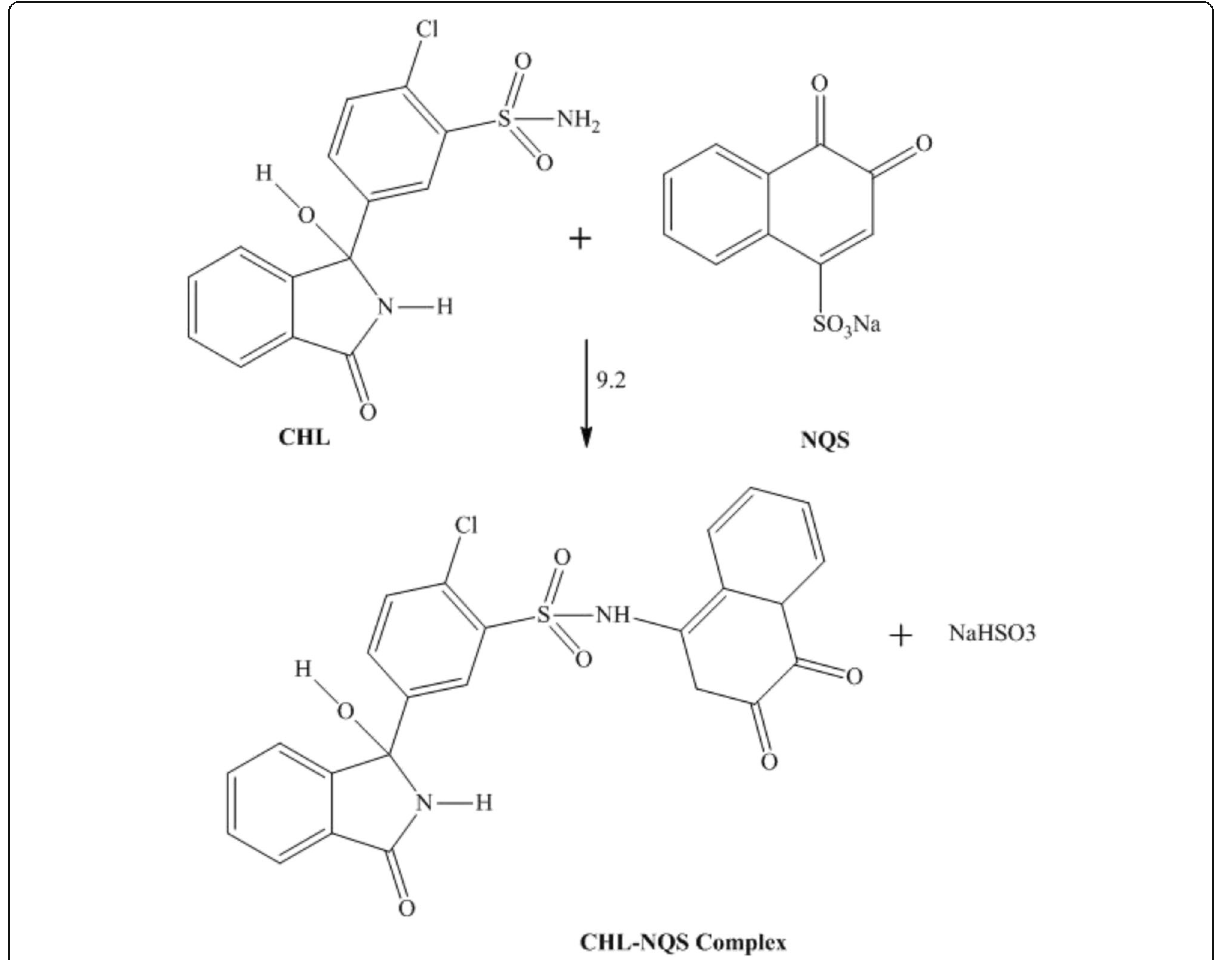
Fig. 7 Reaction scheme for chlorthalidone with 1,